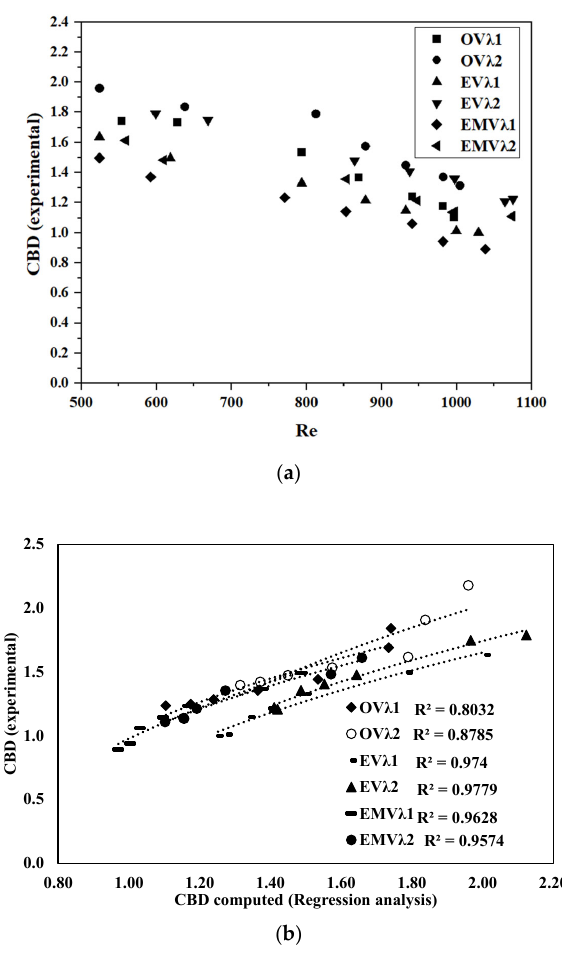
Figure 5. ( a ) Experimental C BD vs. Re and ( b ) relation between experimental and computed C BD . Similarly, the drag coe ffi cient of vegetation ( C BD ) was calculated using Equation (4) The bulk drag coefficient of vegetation ( C BD ) usually represents the resistance to for the composite defense system in the sequence of the embankment, moat/depression, and the vegetation of variable densities. The calculated average values of C BD for EMV λ 1 and EMV λ 2 were 1.16 and 1.29, respectively, based on these two variables, i.e., density and Reynolds number. Finally, Equation (14) was developed by regression analysis to compute the bulk drag coe ffi cient for the EMV λ 1 and EMV λ 2 cases within the selected range of variables. The computed average values of C BD for EMV λ 1 and EMV λ 2 were 1.16 and 1.30, respectively.